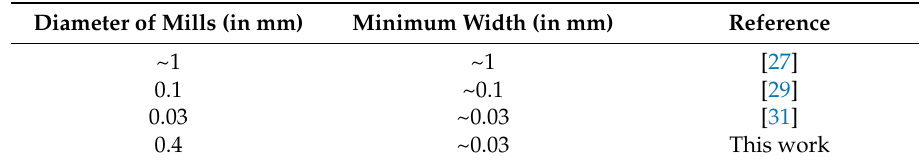
Table 2. Minimum width of positive microchannel milled by different diameter mills, and comparison with minimum width of negative microchannel by micromilling.